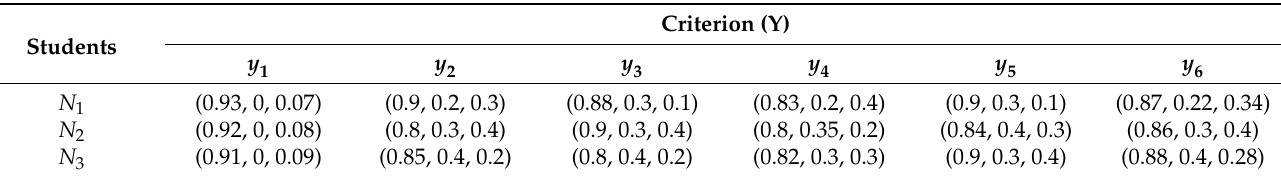
Table 3. Single-valued neutrosophic decision matrix